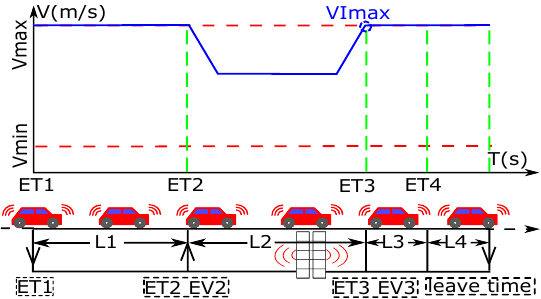
Figure 4. Process of traversing the communication zone.